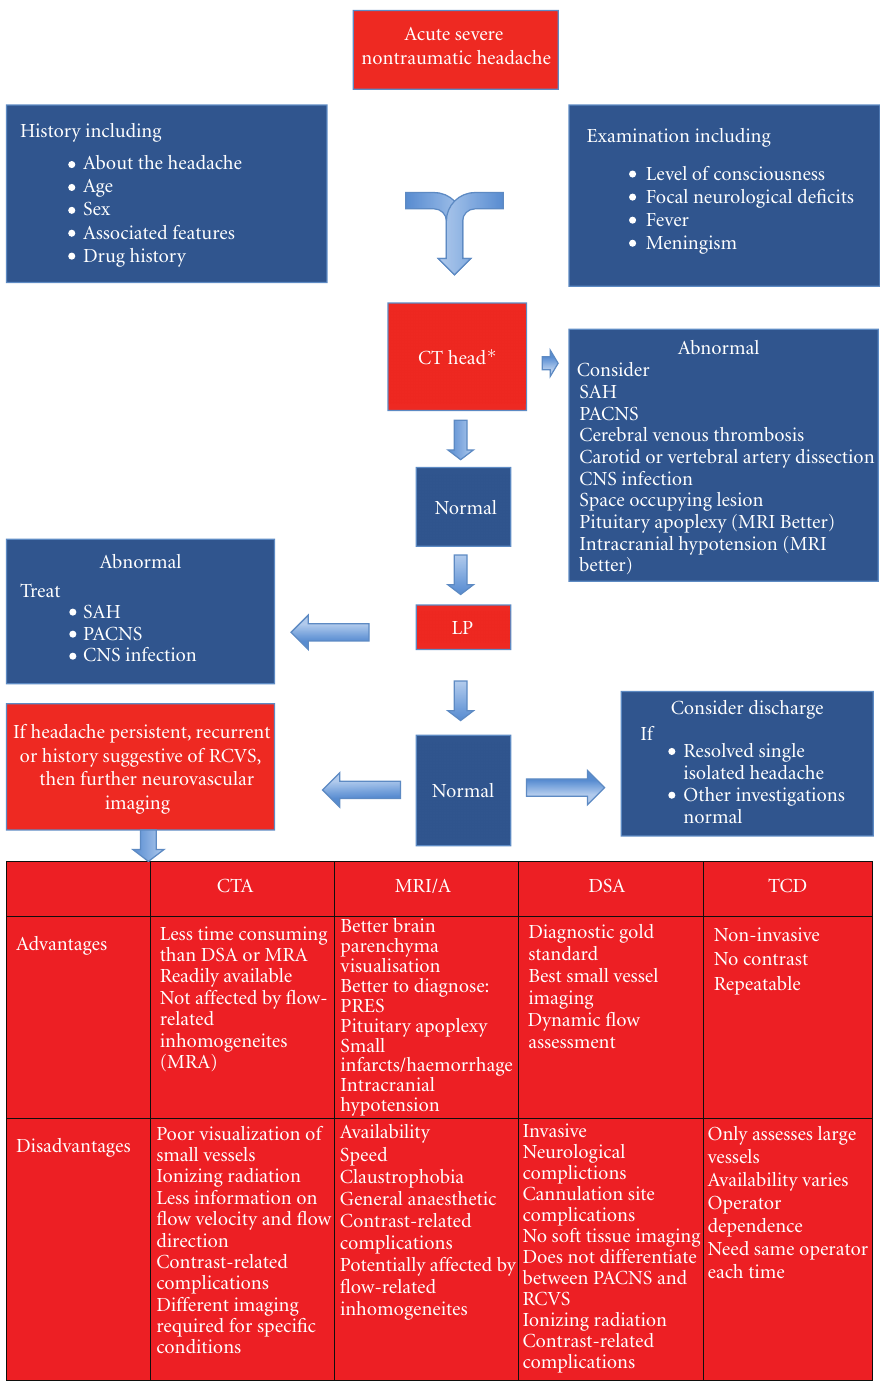
Figure 1: An approach to investigation of RCVS [10]. ∗ CT angiography may be considered at this stage, specifically looking for cervical artery dissection, cerebral venous thrombosis or RCVS, depending on the history, clinical suspicion and contraindications to radiocontrast.